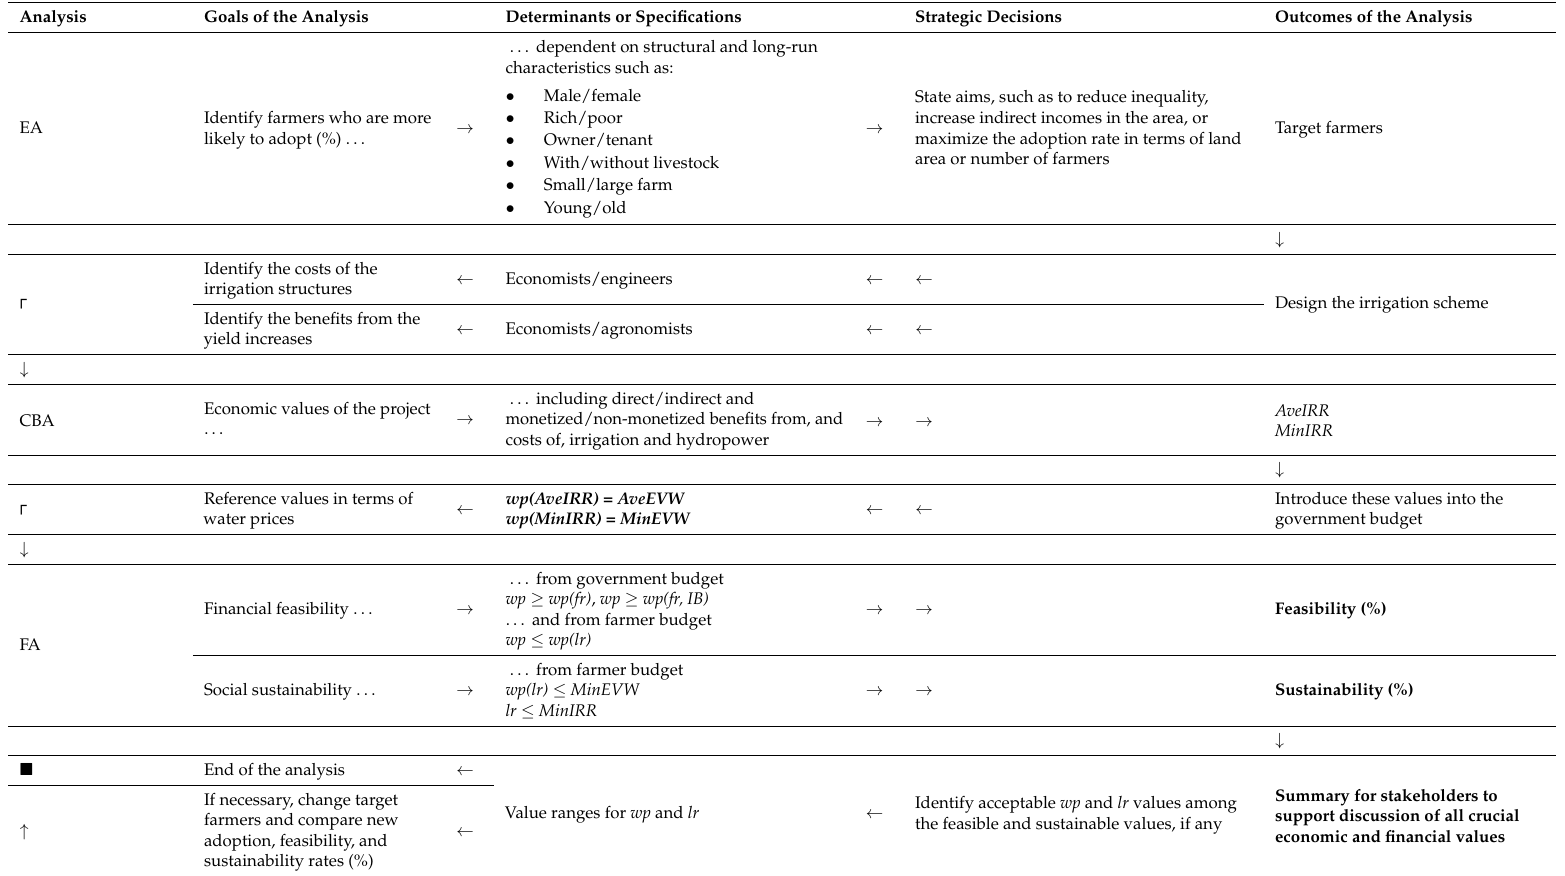
Table 6. Conceptual flow chart of the innovative framework in the present study. Innovative theoretical features are boldfaced. EA, econometric analysis; CBA, cost–benefit analysis; FA, financial analysis; IB, indirect benefits; EVW, economic value of water. Analysis Goals of the Analysis